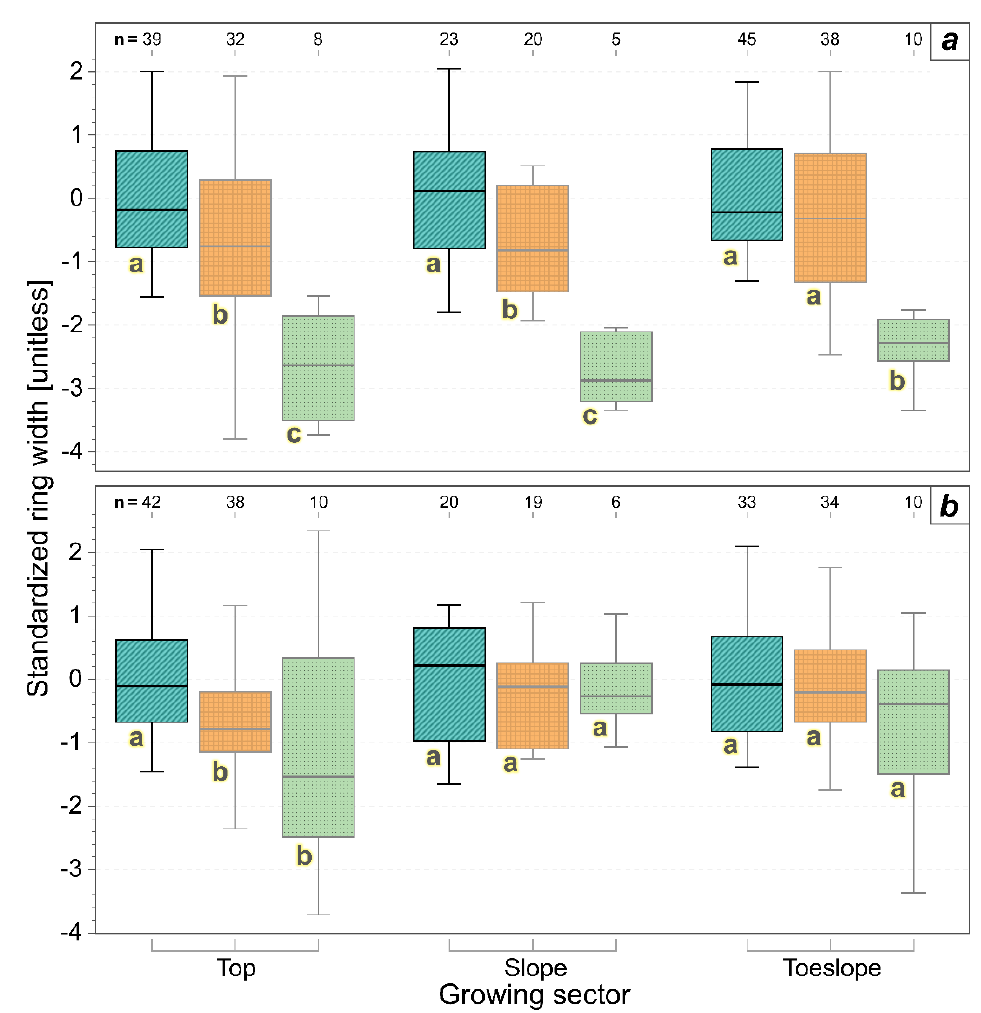
Figure 5. Boxplots of the standardized ring widths of symptomatic and asymptomatic samples during normal years (cyan, lines), drought years (orange, grid), and the year of symptom expression (i.e., 2019, green, dots). ( a ) symptomatic samples; ( b ) asymptomatic samples. The letters indicate significant differences (Kruskal–Wallis paired-test, p < 0.05) within-group for each growing sector.